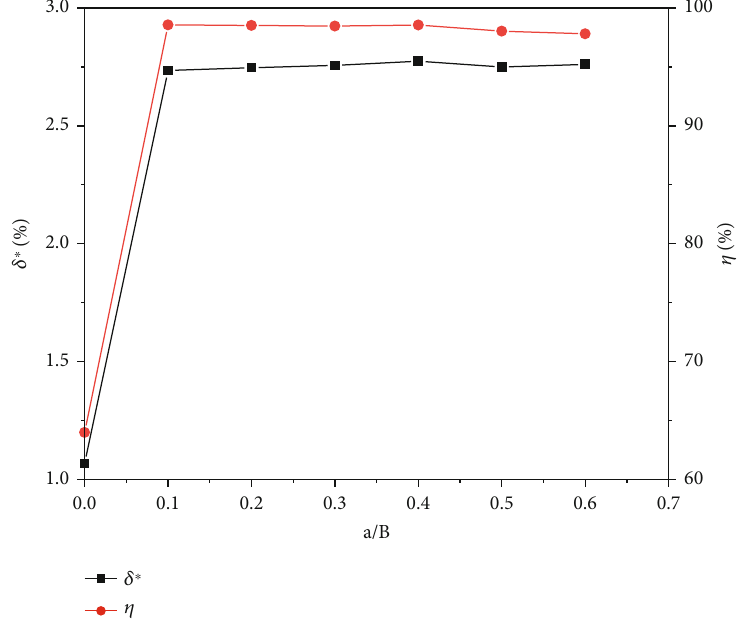
Figure 10: Total pressure loss and combustion e ffi ciency under di ff erent a / B